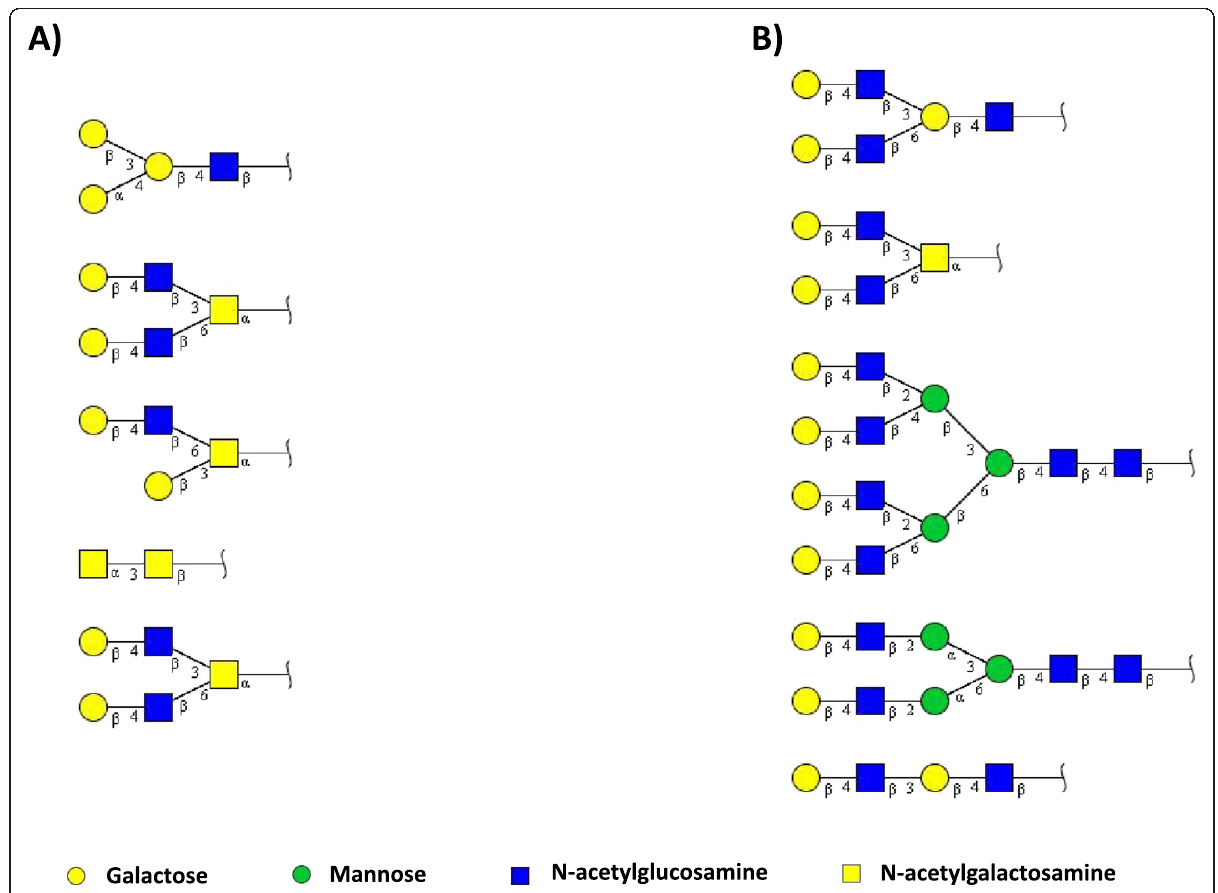
Fig. 3 Glycan-recognition specificity. Top five glycan structures with highest binding recognition by the SVgalLs ( a ) RSL and ( b ) galatrox assessed by glycan microarray as described elsewhere [34,